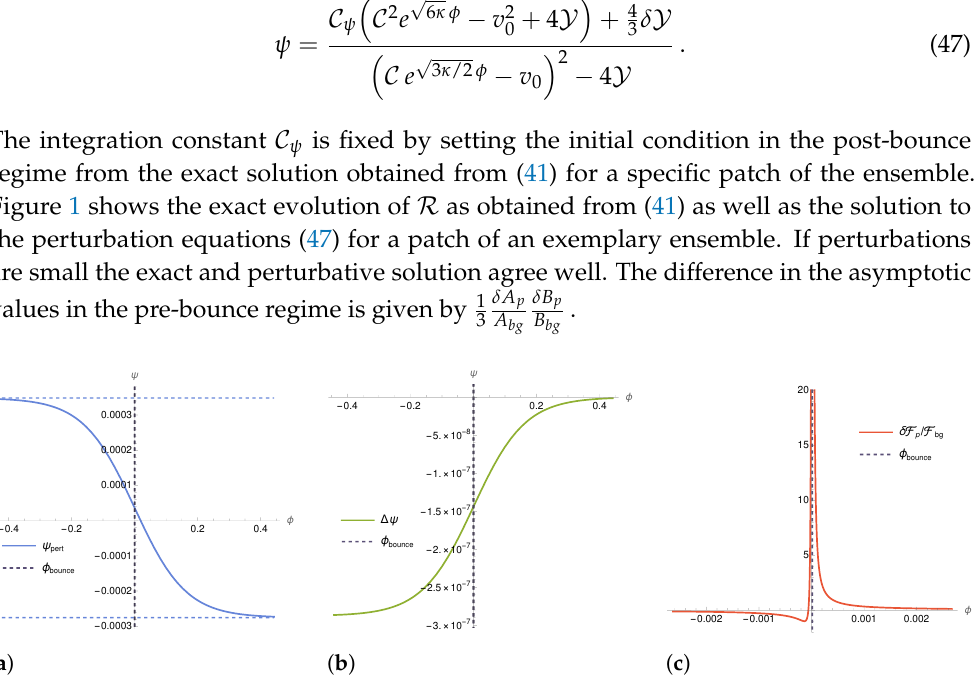
Figure 1. ψ for a single patch of an ensemble with N patches = 16 (see also Figure A1) as given in (47) ( ψ pert ) compared to the exact solution (41) ( ψ exact ). The difference between the two solutions increases in the bounce region and asymptotically approaches a constant value, but remains small throughout. Initial conditions are set in the post-bounce regime at φ = 4. The asymptotic values of ψ are given by (A17) and (A18). While the qualitative behaviour of the plots and the conclusions we draw in the main text are independent of the specific choice of initial conditions, we quote the numerical values of parameters in the solution of ψ pert for reference: A bg = 200.226, B bg = 200.262, Y = − 160390, C = 800.903, δ Y = 35.0685, C ψ = 2.75576 × 10 − 4 , v 0 = 1. The bounce time is φ bounce = 1.47351 × 10 − 5 and we set κ = 8 π . ( a ) The evolution of ψ pert (47) in an exemplary patch. The horizontal dashed lines represent the asymptotic values of the solution (A18). ( b ) The difference between the exact solution (41) and the solution obtained from the perturbation equations (47), ∆ ψ = ψ exact − ψ pert . ( c ) In the F p immediate vicinity of the bounce δ F bg is large, indicating a breakdown of linear perturbation